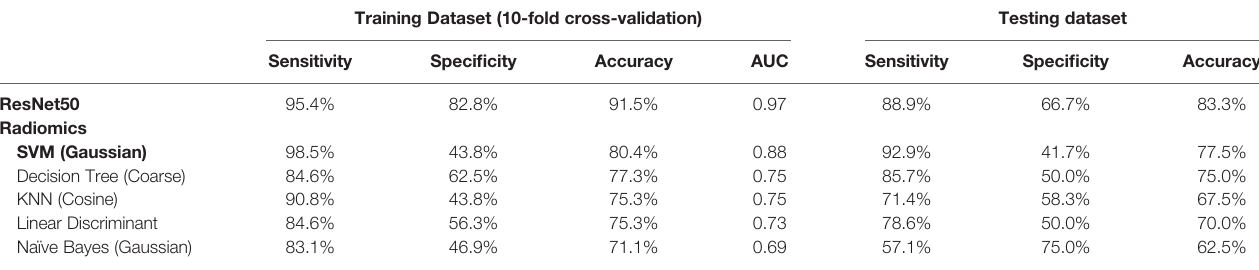
TABLE 4 | Diagnostic sensitivity, speci fi city, and accuracy using models built by ResNet50 deep learning and radiomics with fi ve different machine learning